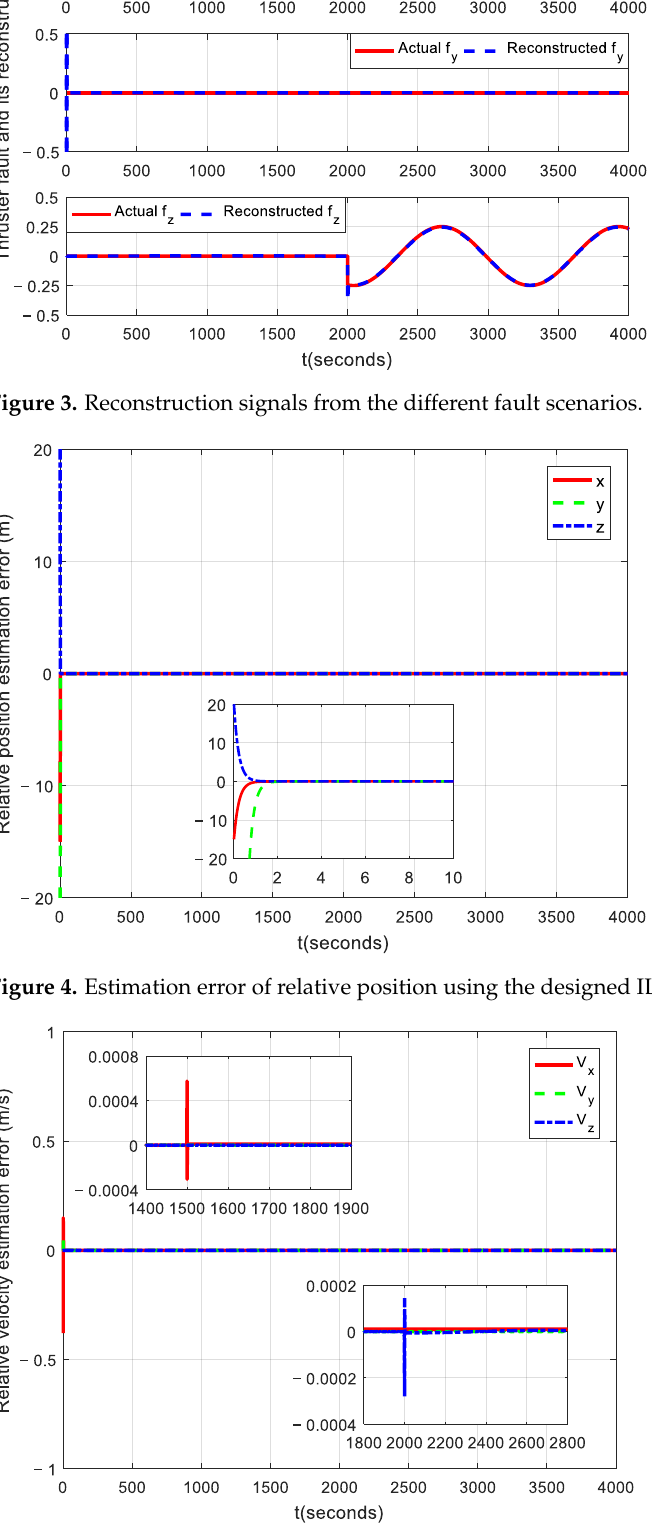
Figure 5. Estimation error of relative velocity using the designed ILO.